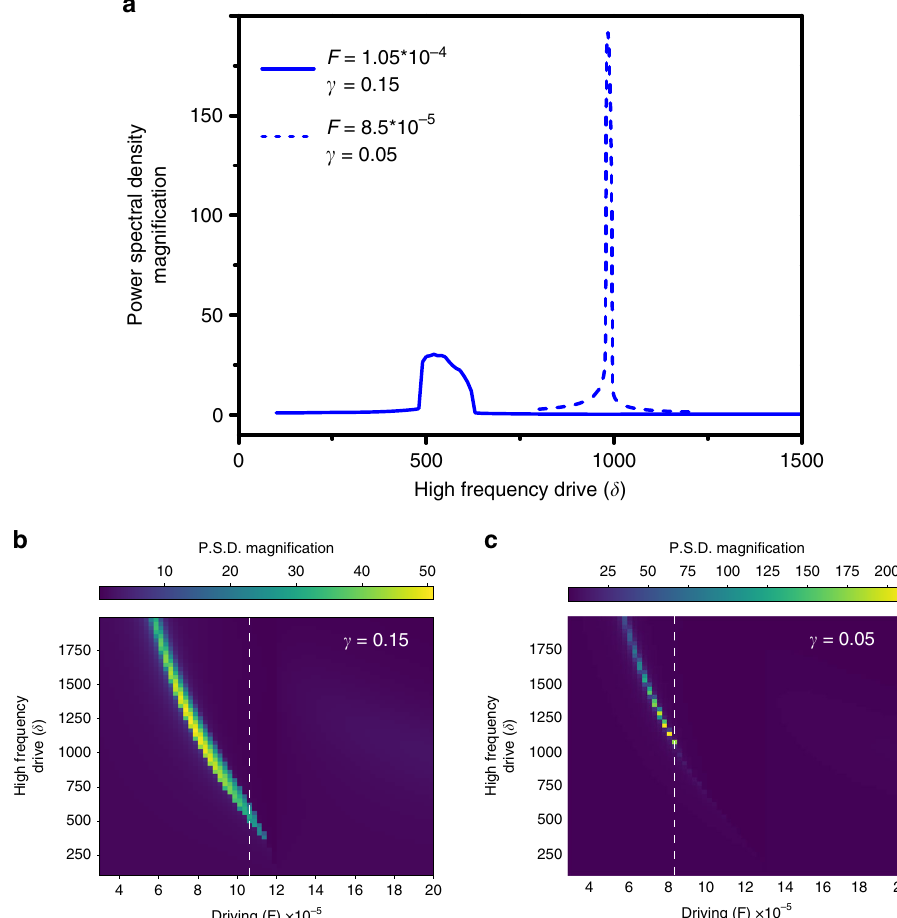
Fig. 5 Simulated power spectral ampli fi cation for vibrational resonance. a Power spectral density ampli fi cation M = PSD ( ω , δ )/ PSD ( ω , 0) as a function of the high-frequency drive. Parameters for the solid blue line are : σ = 0.0016, η = 0.001, α = 0.4, ω = 2 π /200,000, F = 1.05 × 10 − 4 and γ = 0.15. The parameters for the dashed blue line are the same except F = 8.5 × 10 − 5 and γ = 0.05 (lower resonant and low-frequency drivings). b Evolution of the power spectral density magni fi cation as function of the forcing ( F ) and the detuning ( δ ) for b γ = 0.15 and c γ = 0.05. White dashed vertical lines represent the cut at drivings used in a